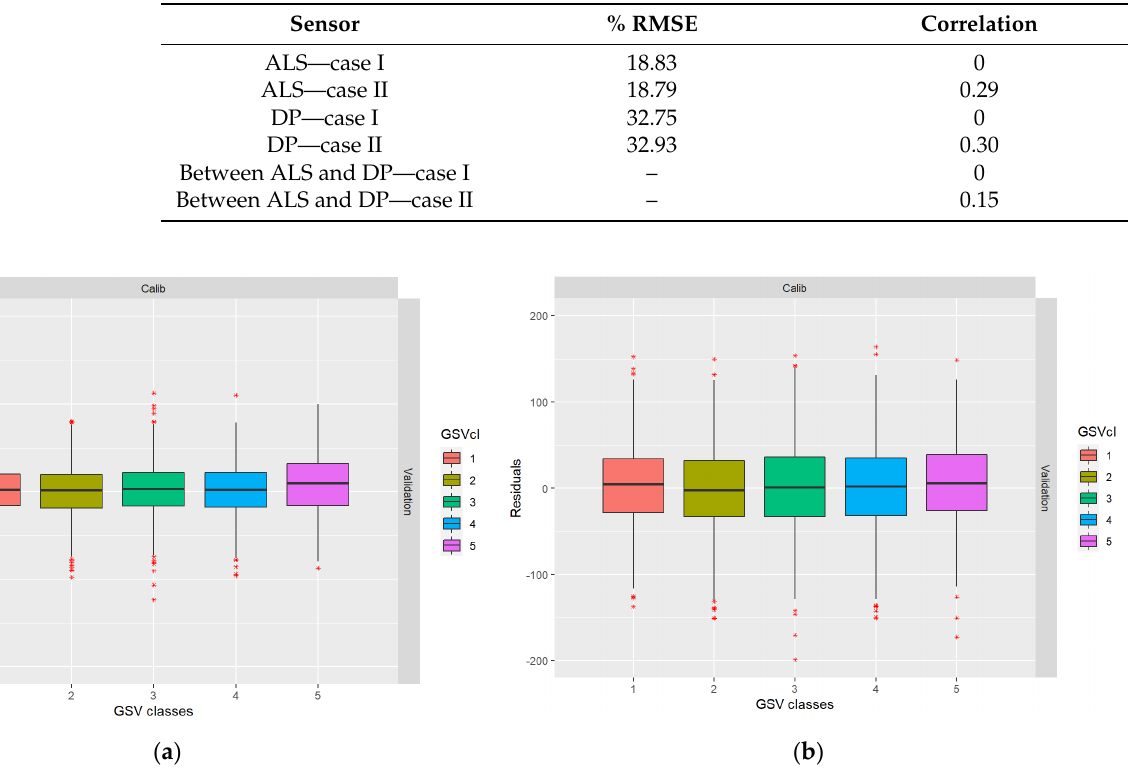
Figure 5. Post-calibration boxplots showing the distribution of residuals across the range of true values: ( a ) ALS-based residuals; ( b ) DP-based residuals.